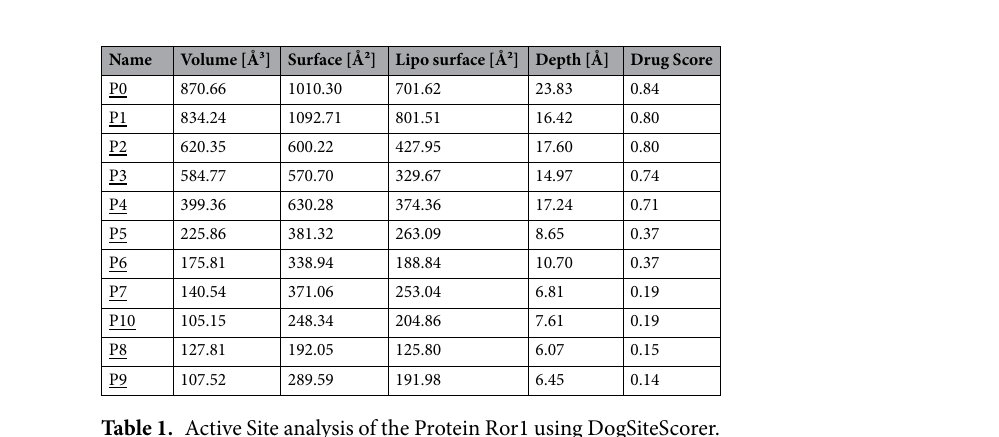
Figure 2. Template search using BLASTp tool.